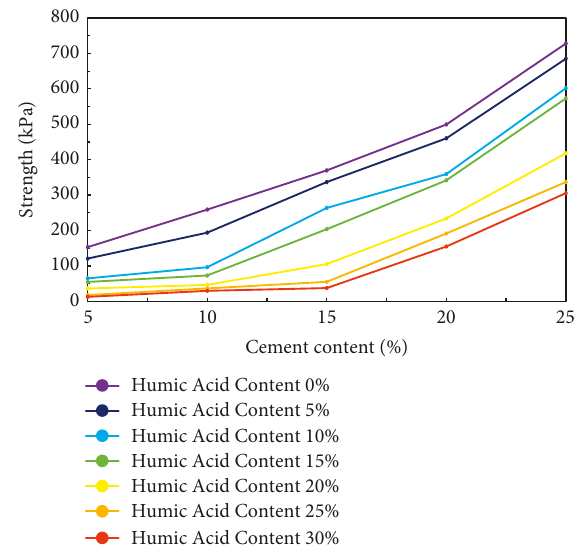
Figure 7: Relationship between the strength and the cement ratio with 365d curing.